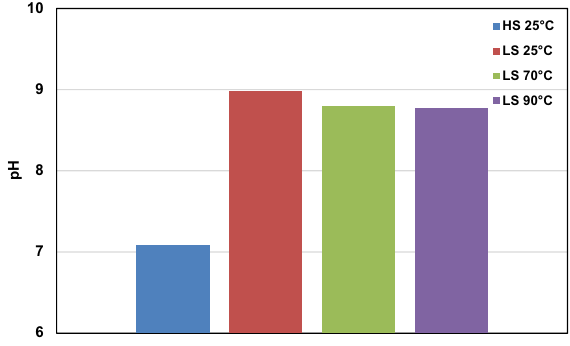
Fig. 3 Effluent pH profile at 25, 70, and 90 °C for core#1